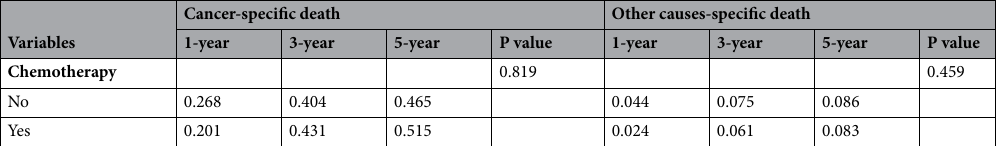
Table 6. Cumulative cancer-specific death and other causes-specific death of patients with HCC between the non-chemotherapy group and chemotherapy group.